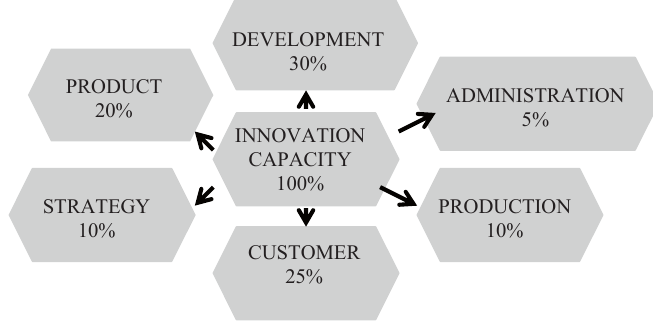
Fig. 1 - Core motivation pillars by process engineer about internal production/administration processes